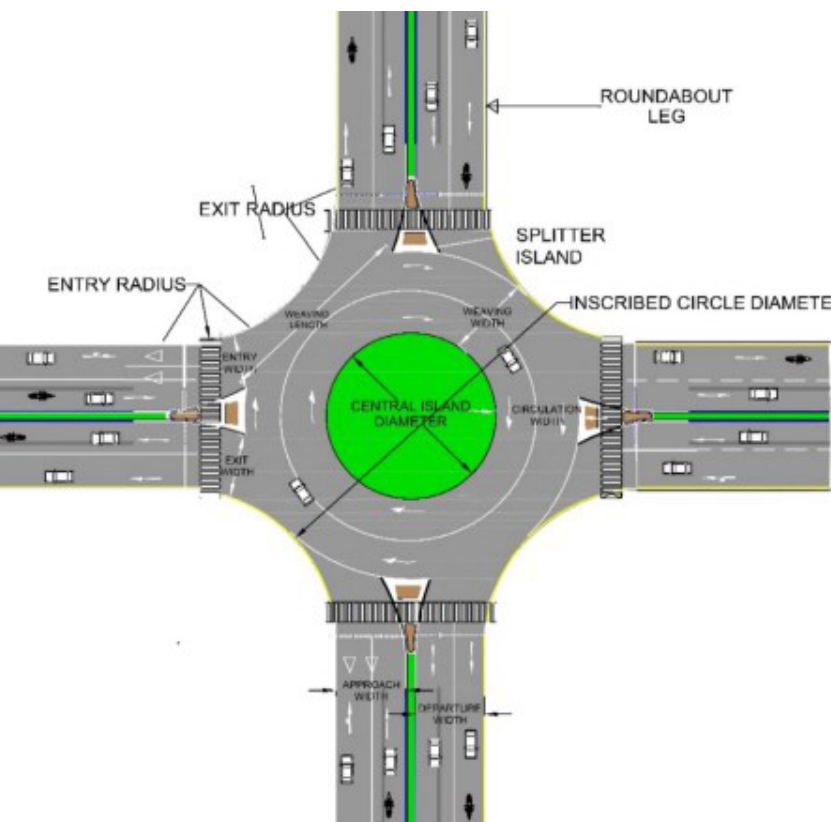
Figure 1 Geometric features of a typical roundabout